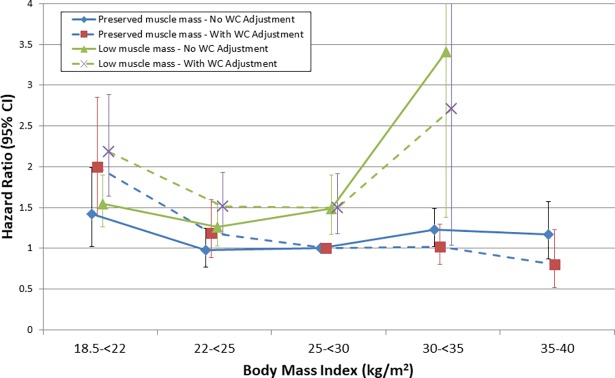
Risk of mortality by BMI category and muscle mass status, without and with adjustment for waist circumference.Y-axis truncated for clarity (see S6 Fig for untruncated y-axis). Models adjusted for age, sex, race/ethnicity, smoking status, physical activity level, and education. Error bars represent 95% confidence intervals.